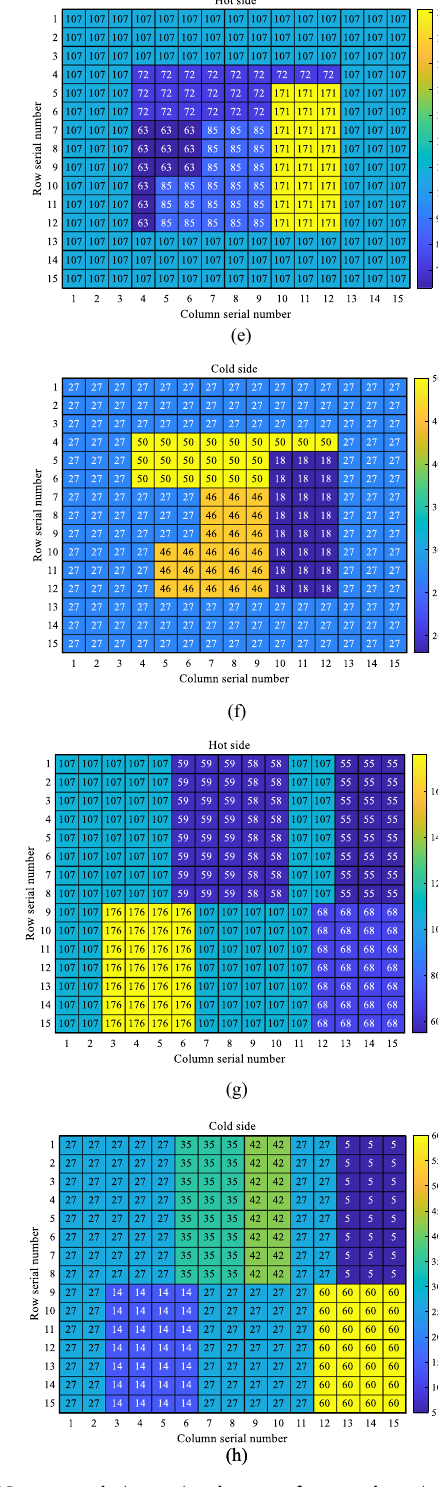
15) TEG system: a , b diagonal, c , d outer, e , f inner, g , h ×